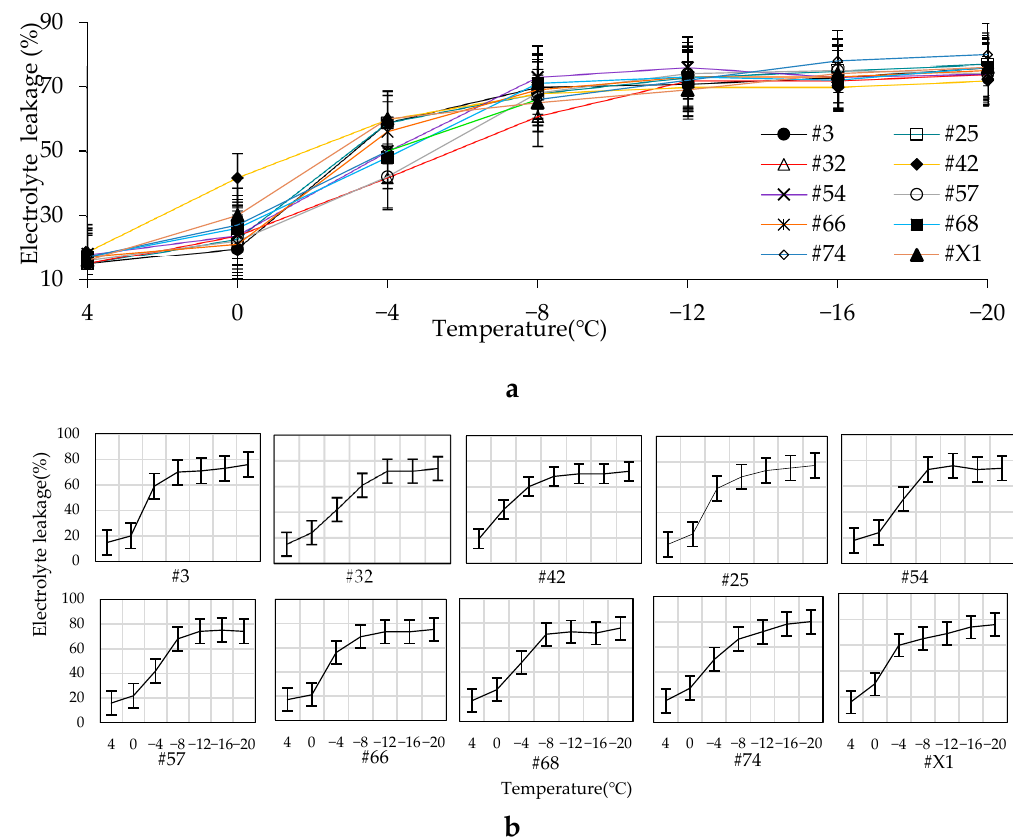
Figure 1. ( a ) Variations of electrolyte leakage of 10 C. fortunei clones under low-temperature stress. ( b ) The electrolyte leakage of each clone. Displayed is the average ± the standard error, n = 6.